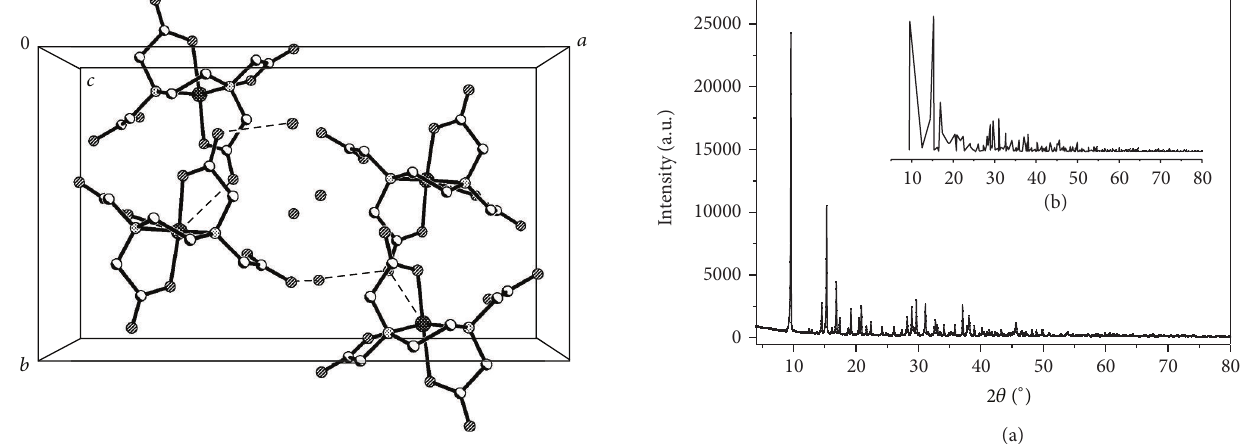
Figure 4: XRD patterns for title complex generated from the experimental data (a) and simulated from the single crystal X-ray data (b).